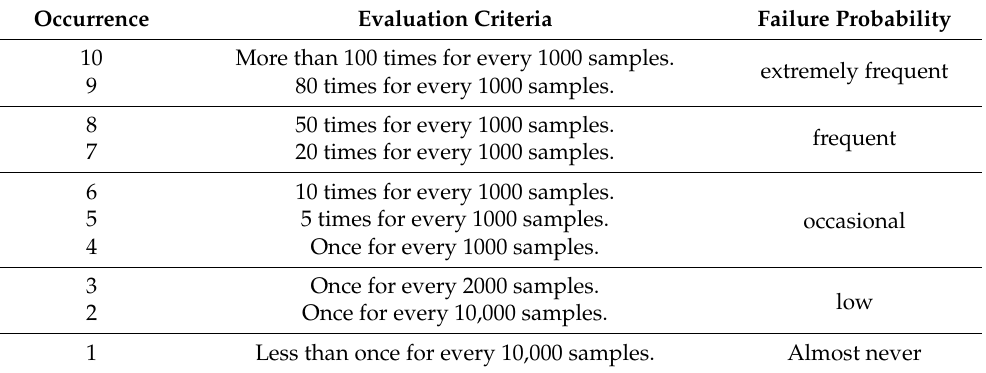
Table 8. Evaluation criteria for FMEA occurrence (O).